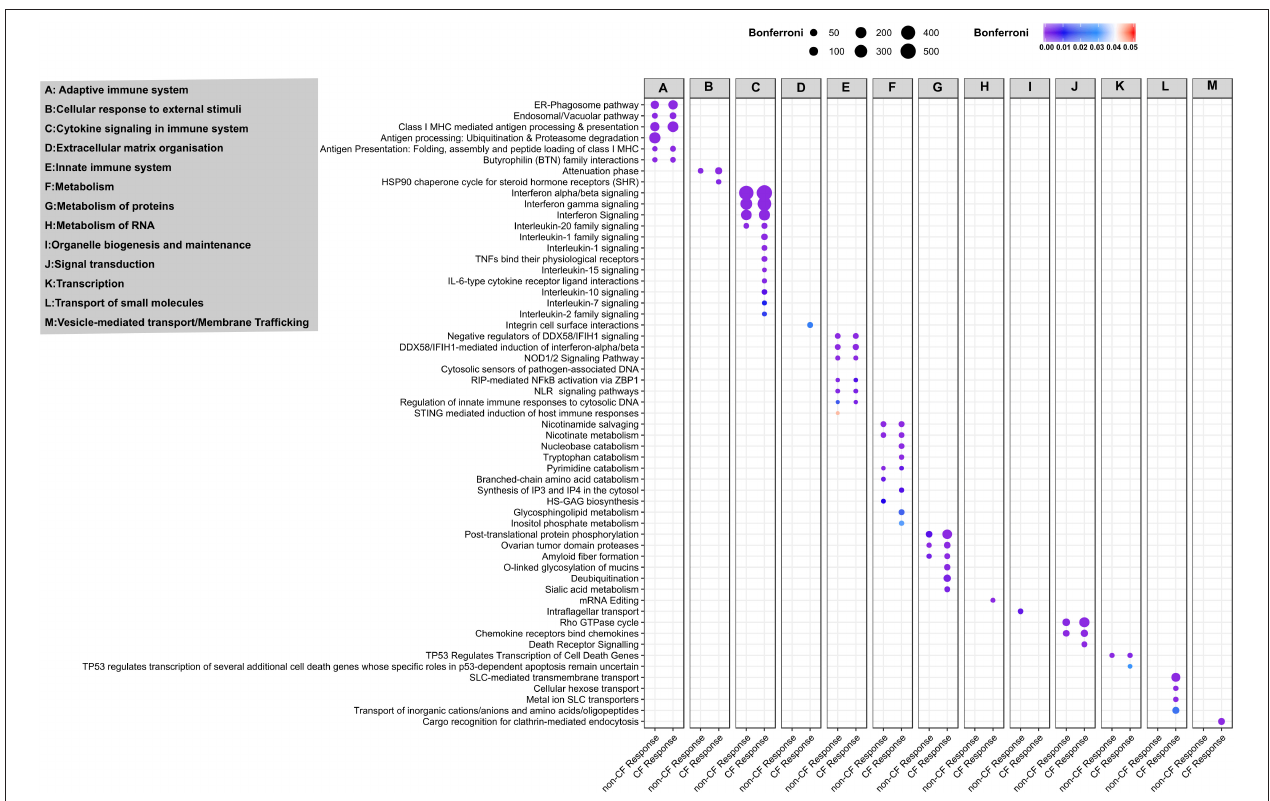
FIGURE 4 | Pathway and network analysis of non-CF and CF AECs response to rhinovirus infection. Pathway enrichment analysis results from 896 and 1,442 differentially expressed genes in non-CF and CF response to rhinovirus infection, respectively. Figure depicting the association of common and unique enriched pathways using Reactome database with the differentially expressed gene lists based on SIGORA successes metric (circle size) and the color bar depicting the significance of the association (Bonferroni < 0.05). The enriched biological pathways are categorized according to functions (A) , adaptive immuno system, (B) cellular response to external stimuli, (C) cytokine signaling in immune system, (D) extracellular matric organization, (E) innate immune system, (F) metabolism, (G) metabolism of proteins, (H) metabolism of RNA, (I) organelle biogenesis and maintenance, (J) signal transduction, (K) transcription, (L) transport of small molecules and (M) vesicle-mediated transport/membrane